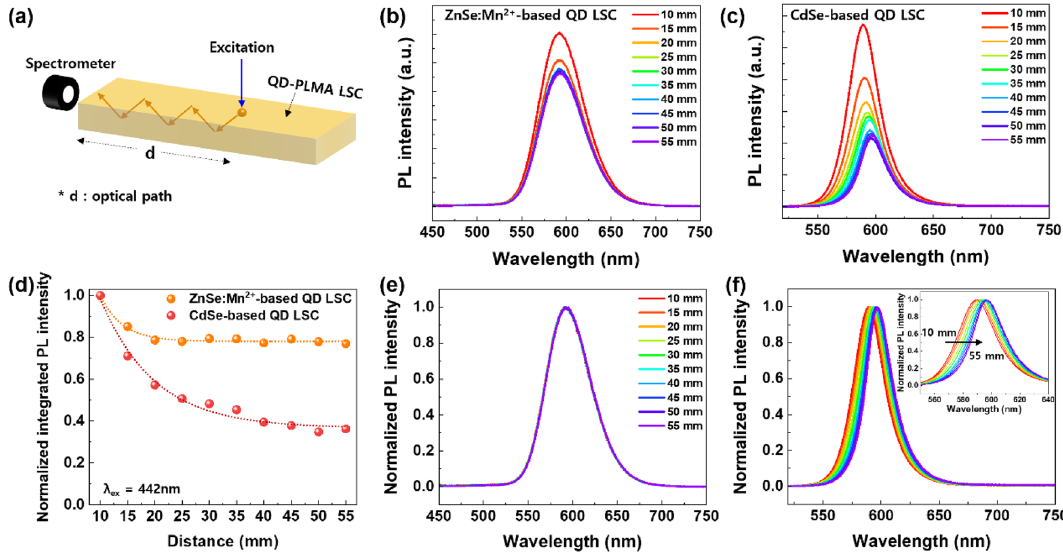
Figure 6. ( a ) Schematic illustration showing measurement of PL spectra from the QD-based LSC films while varying the position of excitation light, and the PL spectra of ( b ) the ZnSe:Mn 2+ /ZnS-PLMA LSC film and ( c ) CdSe/ZnS-PLMA LSC film while varying the distance of the excitation spot from the LSC edge. For optical path-dependent PL measurement, 442 nm light was used as an excitation source. ( d ) Normalized integrated PL intensity of the ZnSe:Mn 2+ /ZnS-PLMA LSC film (orange sphere) and the CdSe/ZnS-PLMA LSC film (red sphere), respectively, while varying the distance between the LSC edge and excitation spot. Normalized PL spectra of ( e ) the ZnSe:Mn 2+ /ZnS-PLMA LSC film and (f) the CdSe/ZnS-PLMA LSC film while varying the distance of an excitation spot from the LSC edge. Inset in (f) shows normalized PL spectra of the CdSe/ZnS- PLMA LSC film in the range from 550 to 640